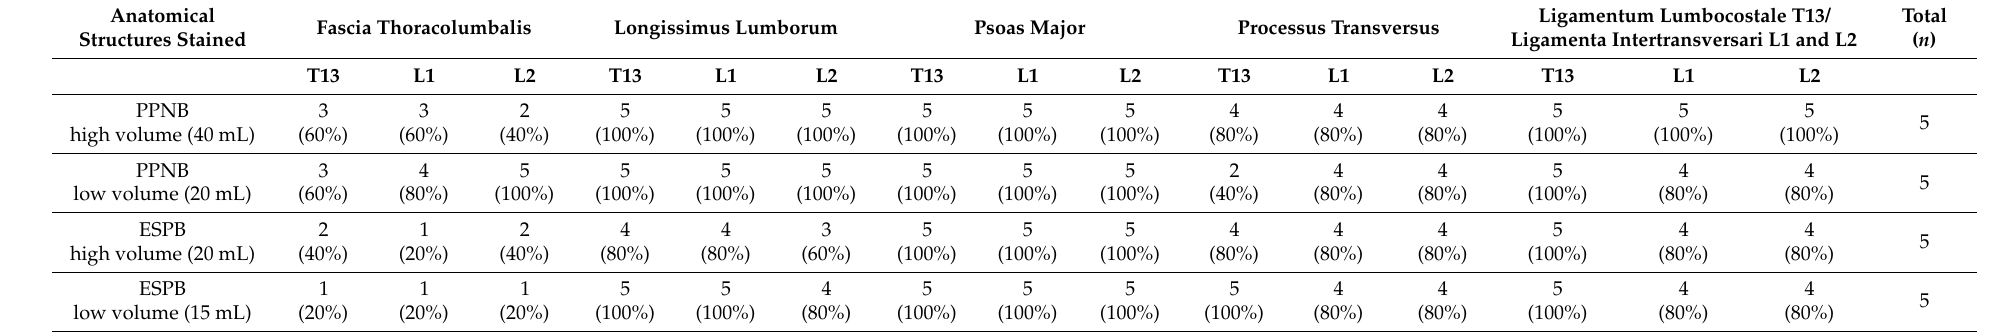
Table 2. Muscles and fascia stained in the different groups (blind proximal paravertebral nerve block (PPNB) high volume (40 mL), PPNB low volume (20 mL), ultrasound guided erector spinae plane block (ESPB) high volume (20 mL) and ESPB low volume (15 mL). Staining was considered positive when at least 2 cm were stained with methylene blue